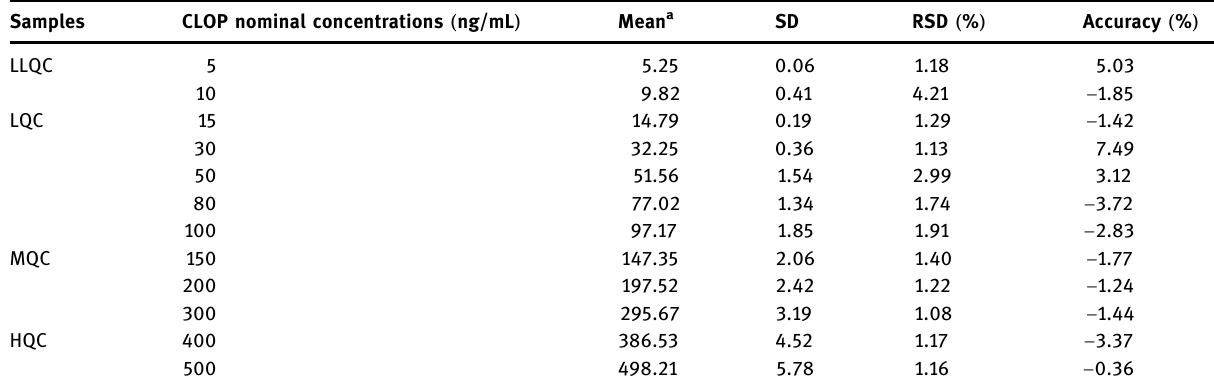
Table 2: CLOP back - calculated calibration standard concentrations from rat plasma matrix